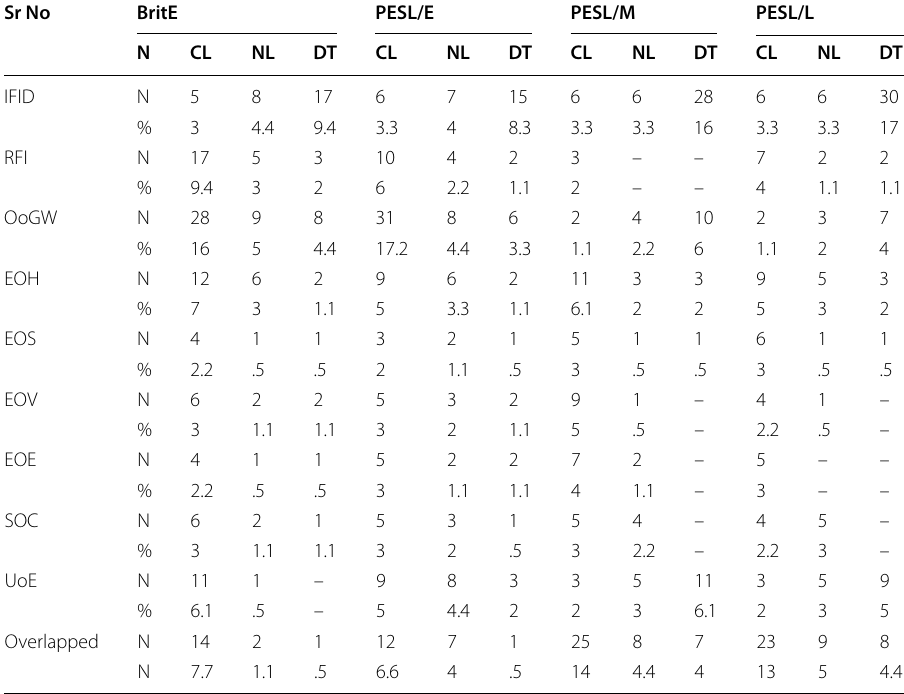
Table 4 Congratulation strategies distribution interacting with social distance Sr No